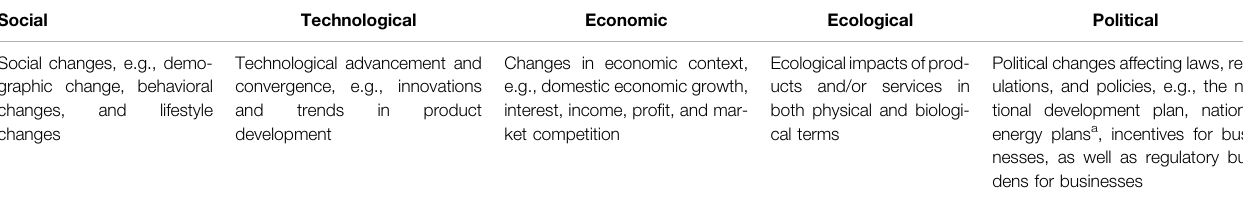
TABLE 1 | Framework of STEEP analysis (PESTLEAnalysis.com, 2015).